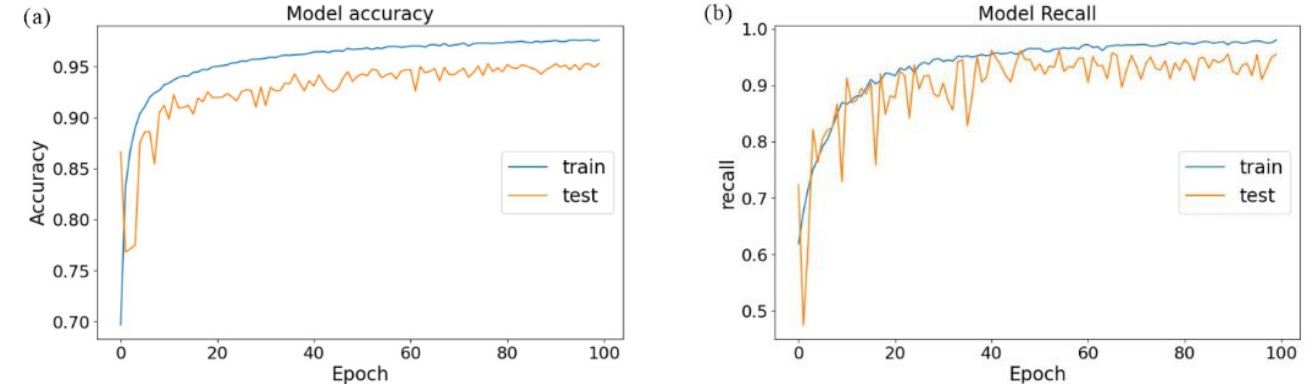
Figure 8. Acc and R evaluation index curves of SE-UNet. ( a ) Acc ; ( b ) R .